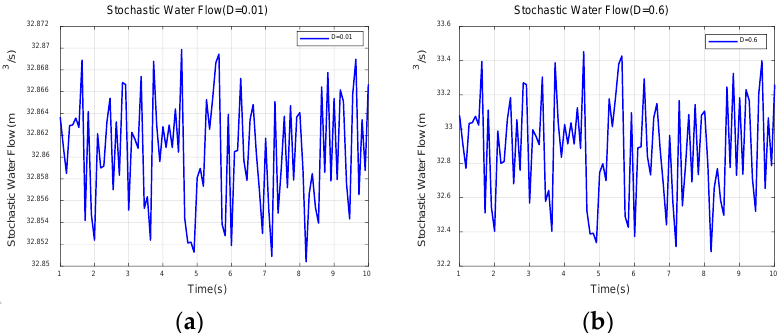
Figure 5. Stochastic water flow model with two stochastic intensity ( a ) D = 0.01; ( b ) D = 0.6.